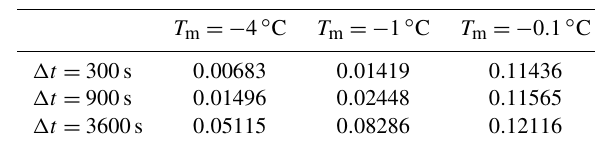
Figure 10. Propagation of the zero isotherm for the Lunardini so- lution and the numerical solution with the NCZ algorithm for the three cases of T1 benchmark: (a) T m = − 4 ◦ C, (b) T m = − 1 ◦ C, and (c) T m = − 0 . 1 ◦ C. The integration time step is (cid:49)t = 3600s, and the space resolution is (cid:49)x = 0 . 01m. Table 3. Maximum absolute error ◦ C of the temperature after 24h from the numerical solution with the NCZ algorithm relative to the Lunardini analytical solution. The space resolution is (cid:49)x = 0 .